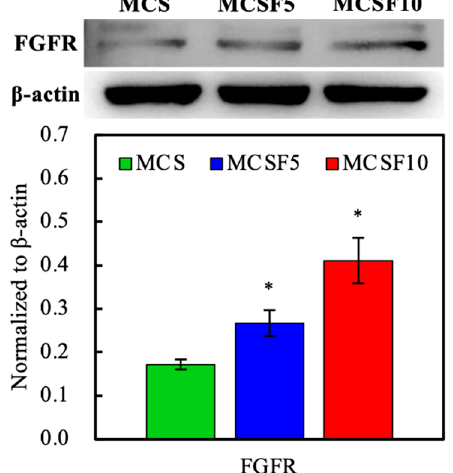
Figure 5. Proliferation of human Wharton’s jelly mesenchymal stem cells (hWJMSCs) cultured on MCS, MCSF5, and MCSF10. * indicates significant difference (p < 0.05) from control (Ctl) group.